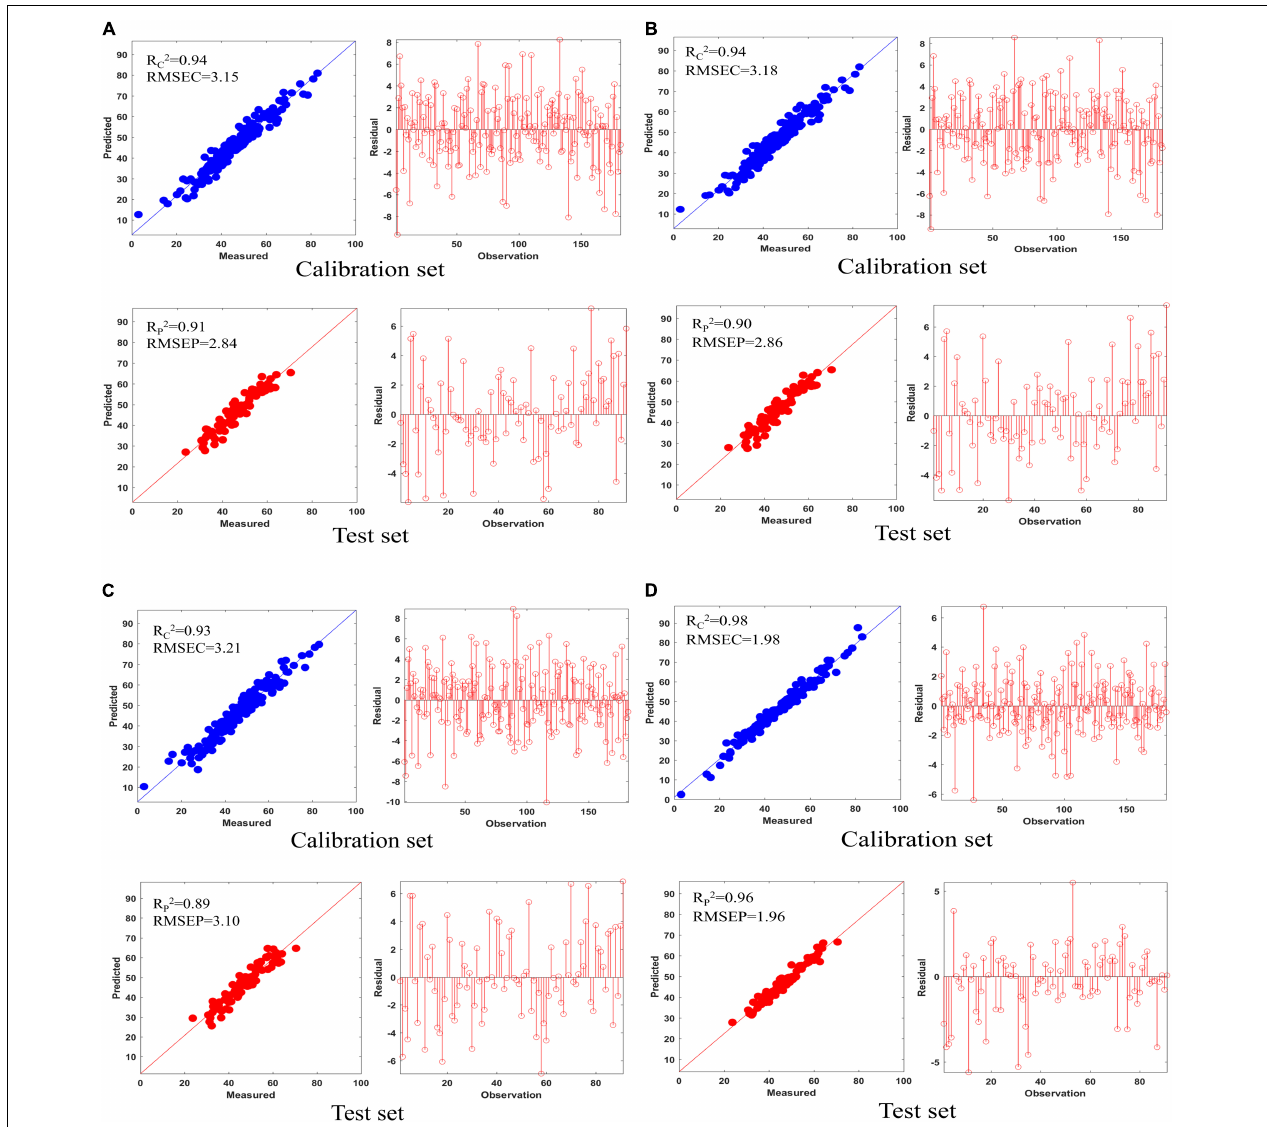
FIGURE 5 | The results of five PLSR models on the calibration set and test set and their residual plot. (A) MSC; (B) SNV; (C) VSN; (D)